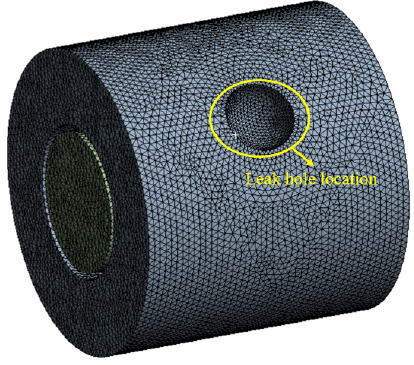
Figure 5. Acoustic grids in the sound propagation